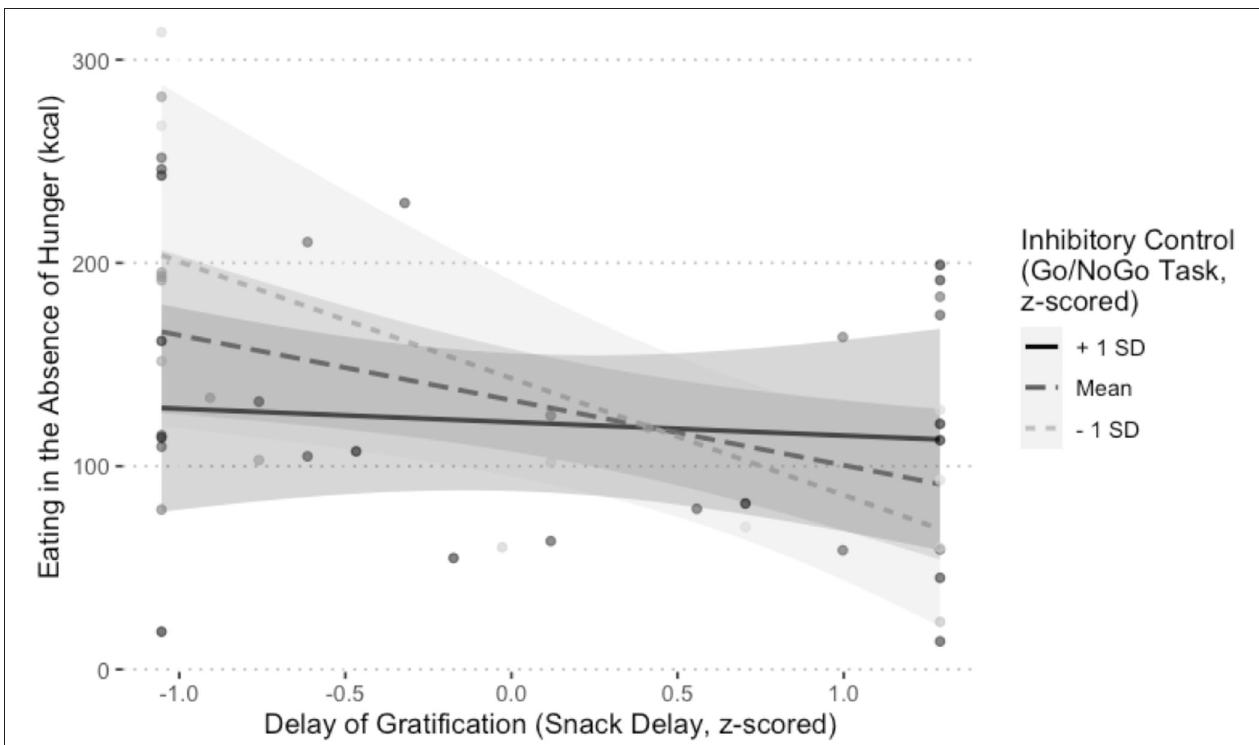
FIGURE 5 | Visualization of the interaction between inhibitory control (Go/NoGo Task) and delay of gratification (Snack Delay Task) on eating in the absence of hunger (EAH), controlling for child age, child sex, child BMI, and the number of calories (kcal) consumed during the lunch test meal, b = 42.22, p = 0.04. One of the multiply imputed data sets was chosen at random for plotting